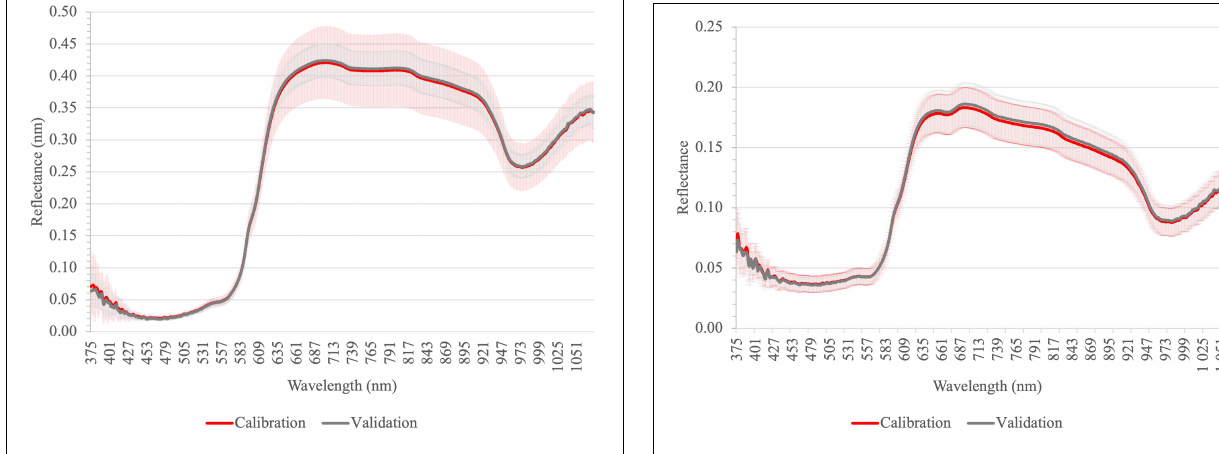
FIGURE 2 | Average reflectance spectra of homogenized tomato fruit samples for calibration and validation in Vis-NIR by ASD; vertical bars represent the standard deviation (calibration n = 144; validation n =